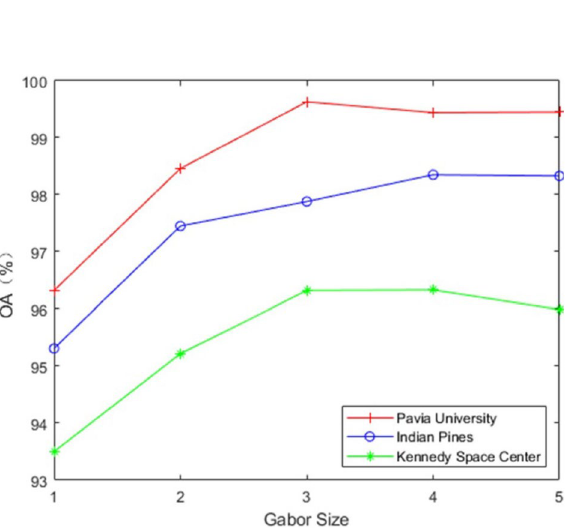
Figure 5. The effect of Gabor window size on three data sets on classification